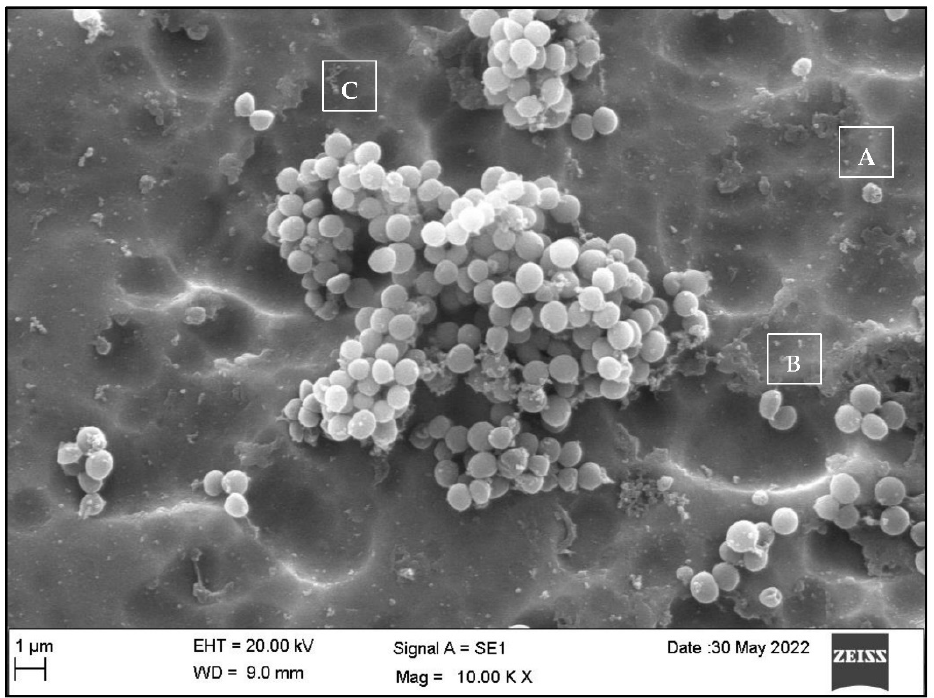
Figure 4. SEM appearance of SA as spherical cocci (A), diplococci (B), or in grape-like clusters (C) at 10 k magnification.